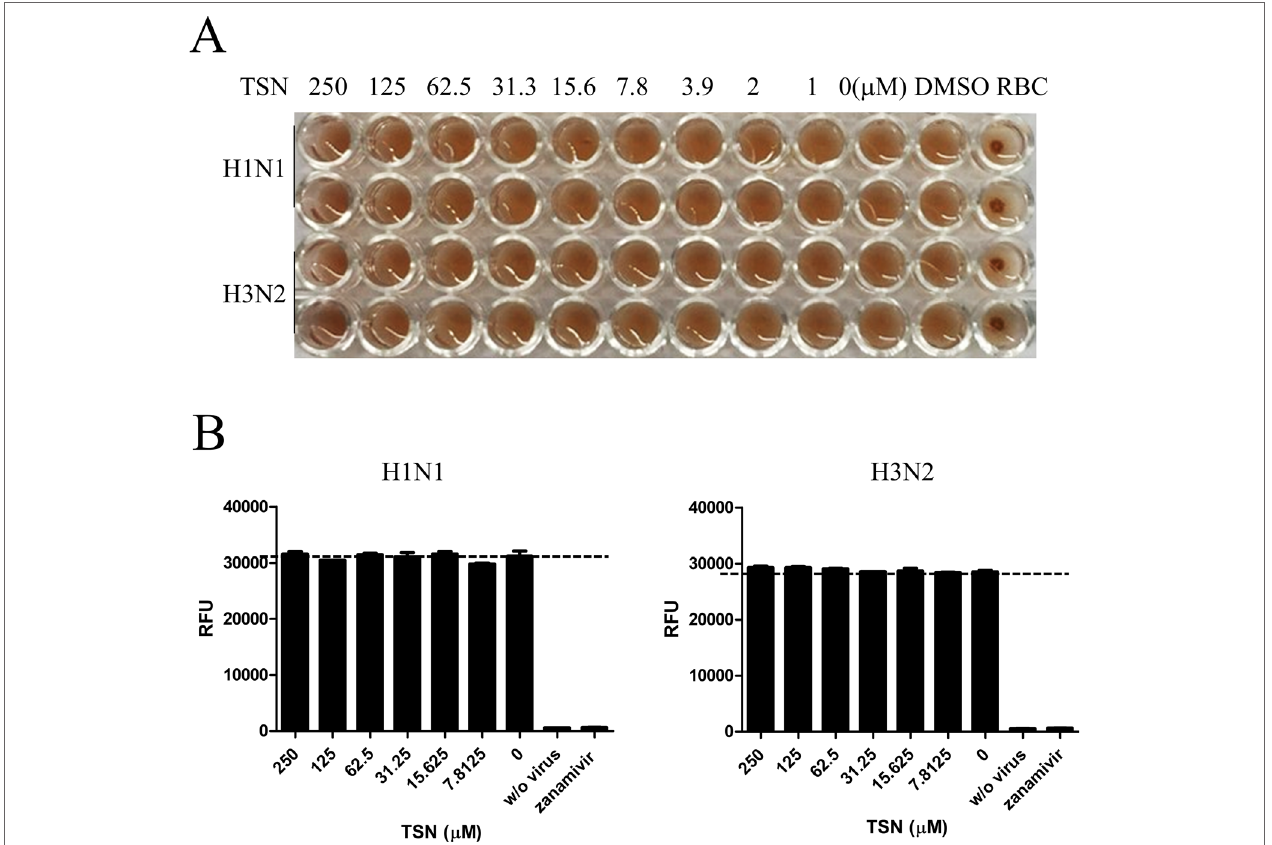
FIGURE 4 | TSN did not inhibit the hemagglutinin (HA) or neuraminidase (NA) activity of influenza A virus strains A/PR/8/34 and H3N2. (A) Influenza virus A/PR/8/34 (upper two lanes) and H3N2 (lower two lanes) were diluted with PBS to 4 HAU and mixed with serially diluted concentrations (up to 250 µM) of TSN for 1 h at 4°C in duplicate. Chicken RBCs in PBS (0.5% w/v) were added and incubated for 1 h at room temperature. The plates were then photographed. (B) Influenza virus A/PR/8/34 or H3N2 in assay buffer was incubated with serially diluted TSN or the known NA inhibitor zanamivir (0.8 µM) as a positive control for 30 min at 37°C. After 1-h incubation with NA-Fluor substrate at 37°C, NA activity was measured by fluorescence spectrometry. Data are presented as mean ± SD of three replicates for three independent